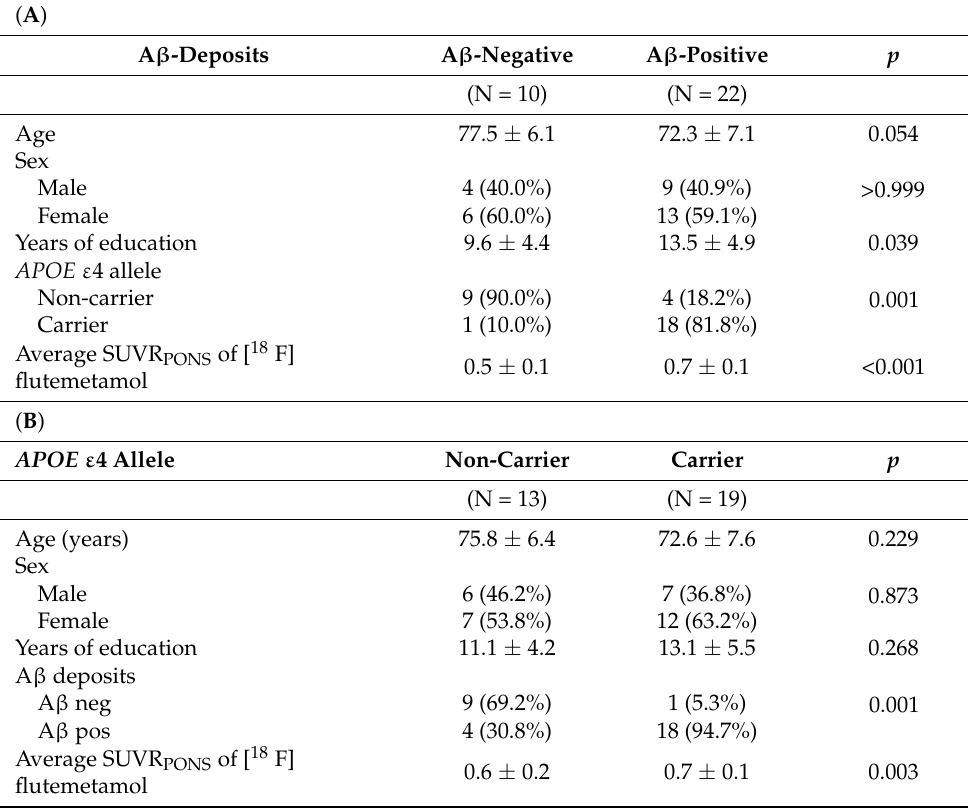
Table 1. Demographic and clinical characteristics of study participants categorized by ( A ) A β deposits and ( B ) APOE ε 4